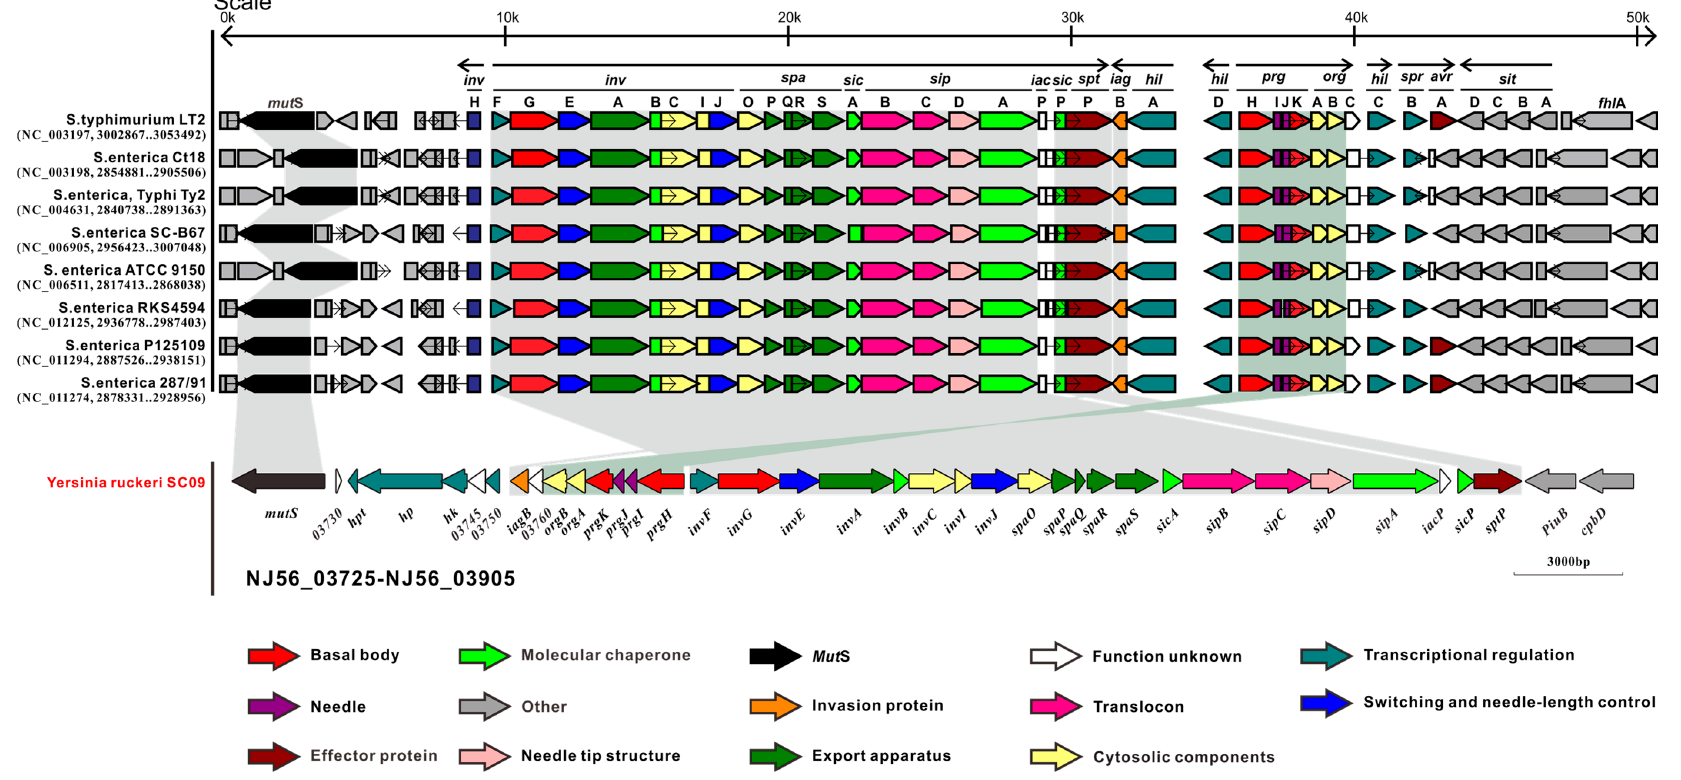
Figure 6. Comparative analysis of the distribution in T3SS between SC09 and SPI1 from Salmonella.